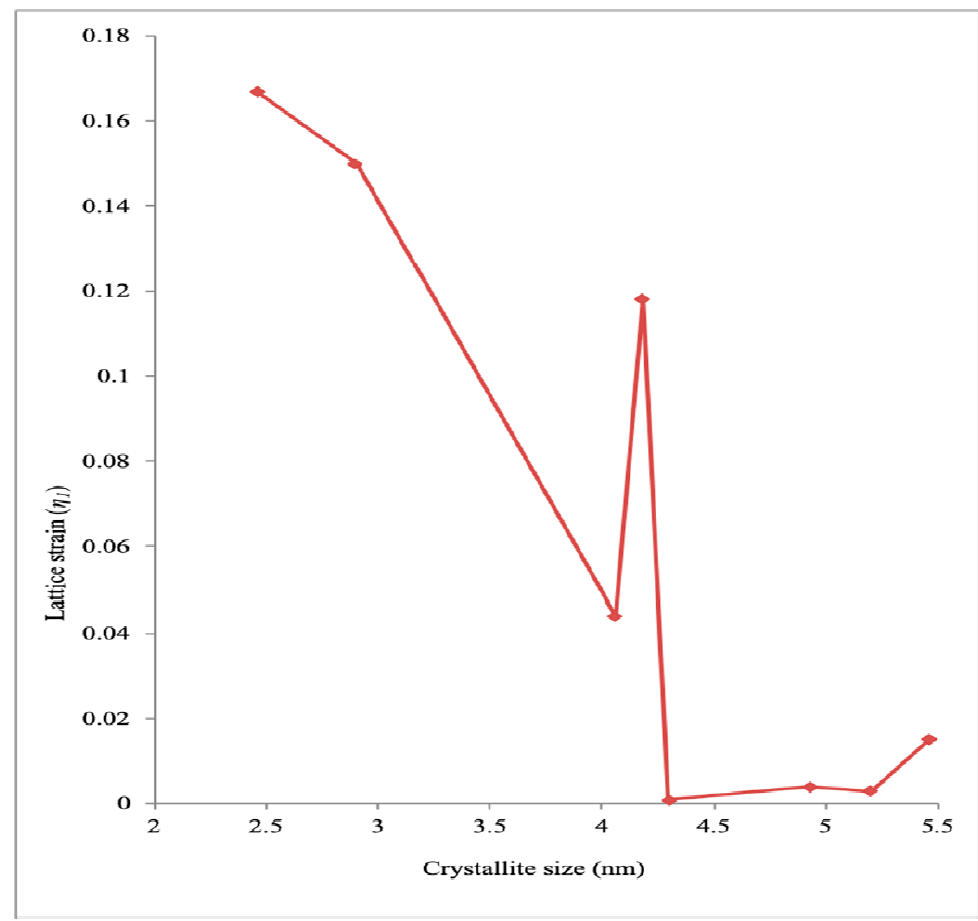
Figure 12. Lattice strain e ff ect with growth of the Mn-doped CdSe QDs’ crystallite size.